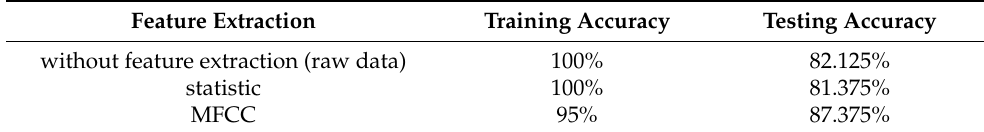
Figure 11. Confusion matrix for ( a ) raw data, ( b ) data with statistic feature extraction, and ( c ) data with MFCC feature extraction on testing stage. Table 3. Training and testing accuracy for the raw data set, data set with statistic feature extraction, and with MFCC feature